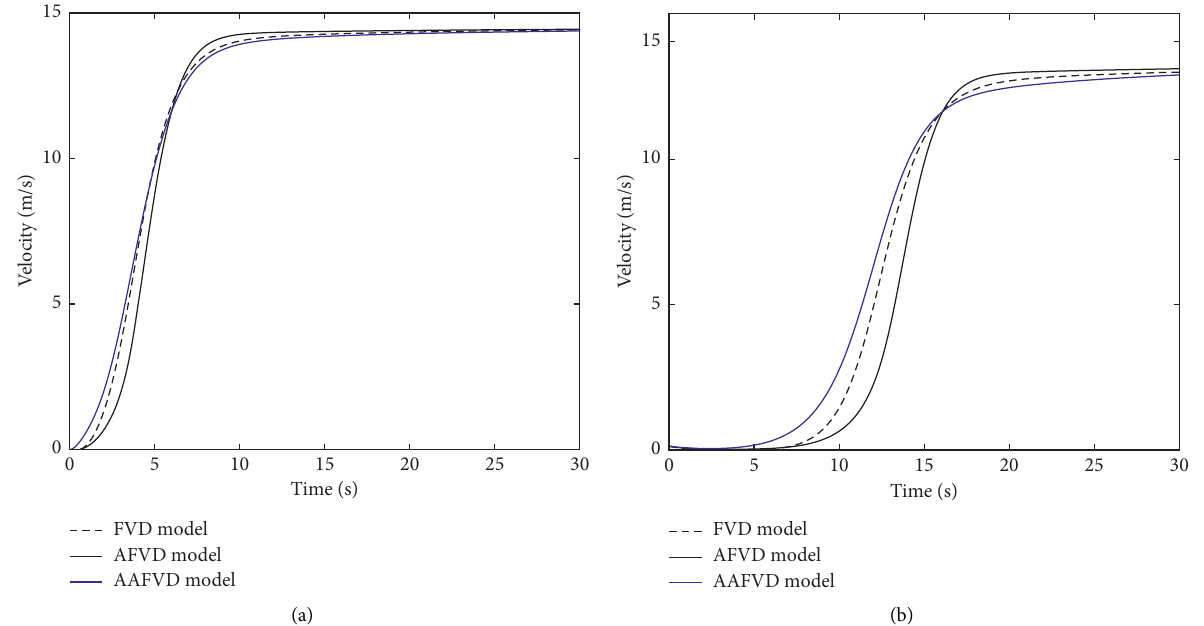
Figure 5: Velocities of two HD vehicles during the departure process simulated by the FVD, AFVD, and AAFVD models: (a) 3 rd vehicle and (b) 9 th vehicle.